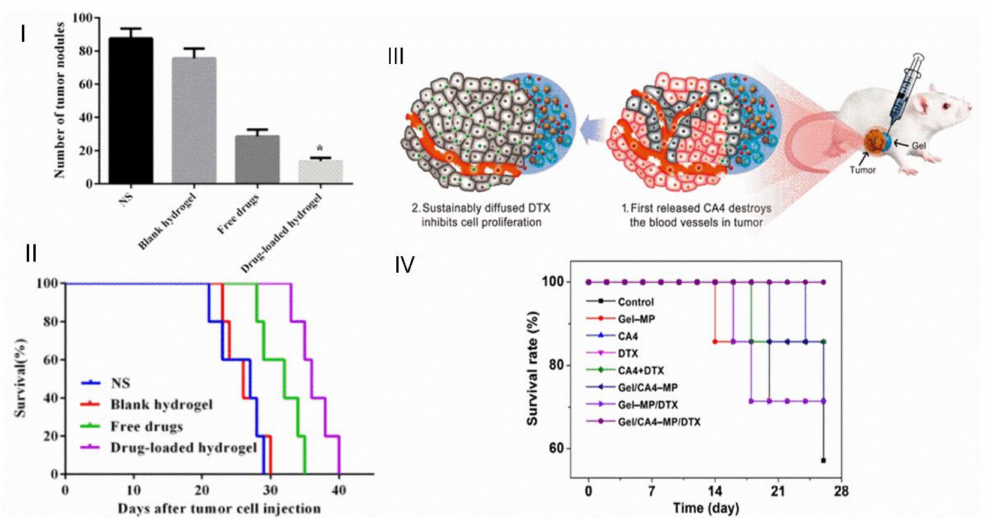
Figure 9. ( I ) Number of tumour nodules in each group; ( II ) survival in each group. (Adapted with permission from [54]. Copyright (2020) Elsevier). ( III ) Scheme of sequential codelivery in a tumour in vivo; ( IV ) survival rate of K7 osteosarcoma-grafted mice after treatment of PBS. (Adapted with permission from [14]. Copyright (2017) American Chemical